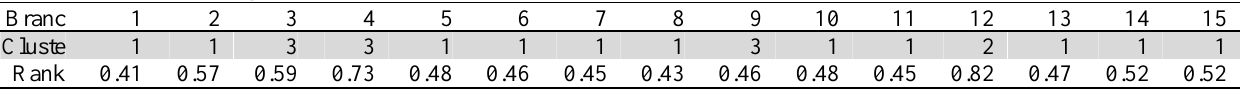
The results of ranking different